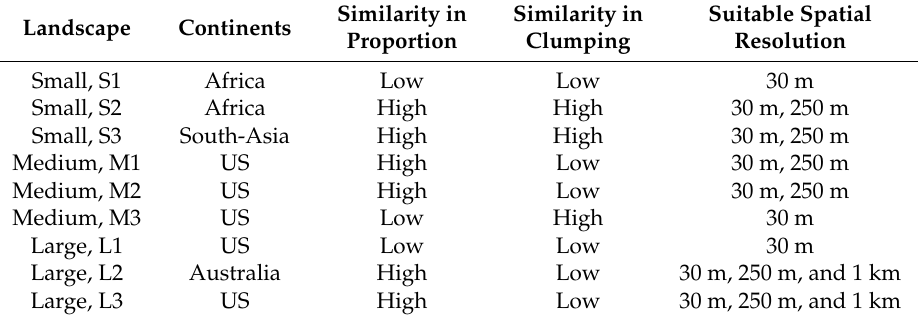
Table 17. The specific recommendations for when to apply the three spatial resolutions of GFSAD cropland extent map with respect to different agriculture field sizes. Similarity in Similarity Landscape Continents Proportion